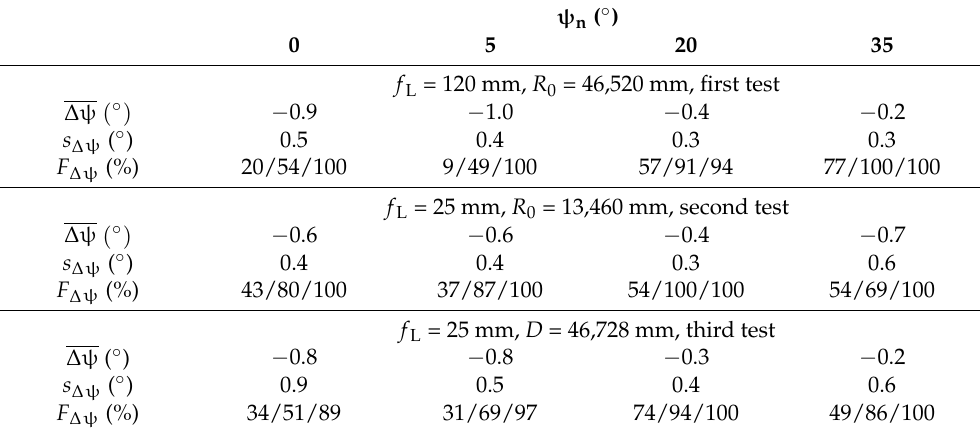
Table 4. Summary of the elevation measurement